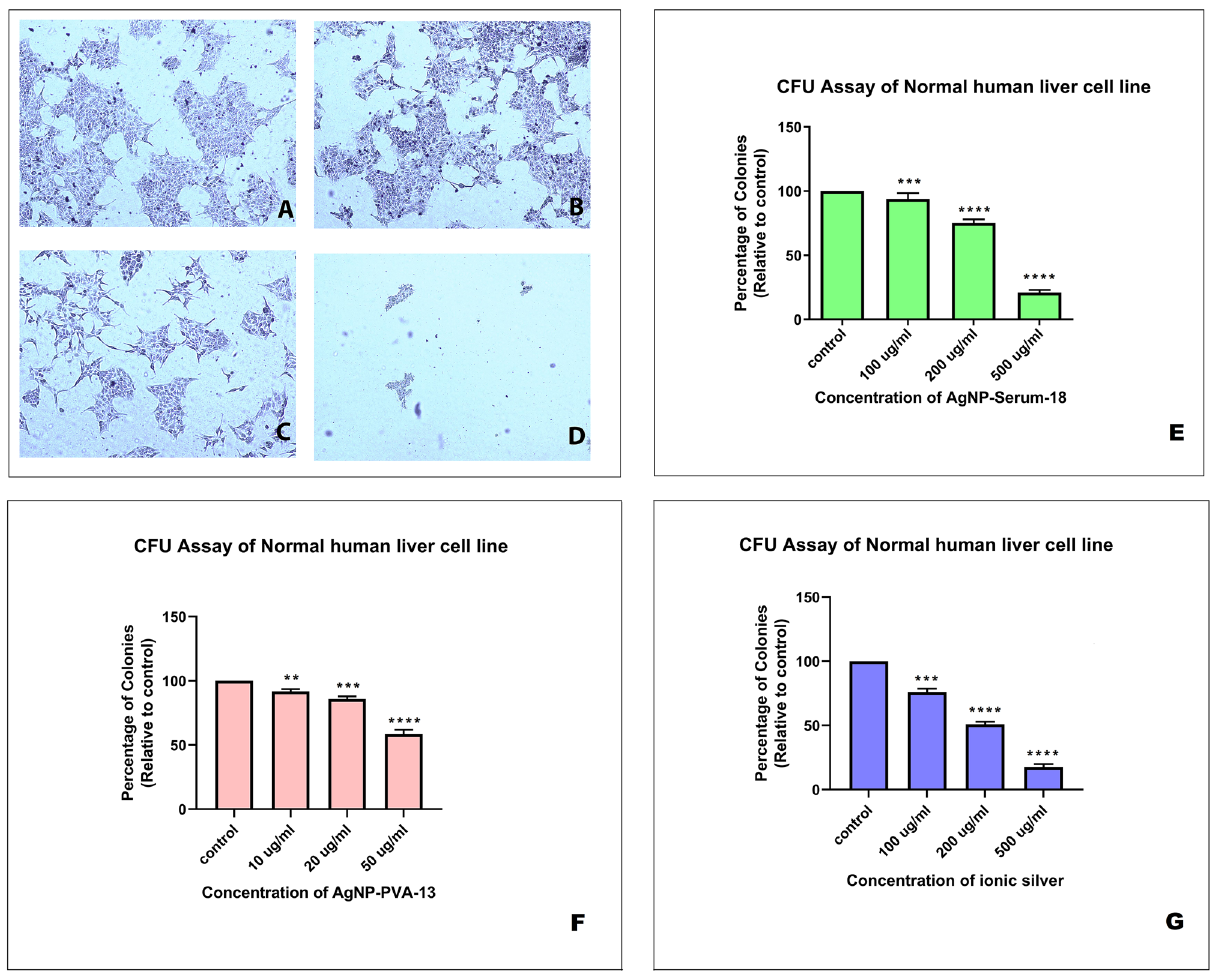
Figure 5. CFU assay. ( A ) Image of a normal human liver cell line (control); ( B ) cell line with the treatment of AgNPs-Serum-18 at 100 µg/mL silver equivalent concentration; ( C ) cell line with the treatment of AgNPs at 200 µg/mL silver equivalent concentration; ( D ) cell line with the treatment of AgNPs at 500 µg/mL silver equivalent concentration; ( E ) percentage inhibition of colony number on normal human liver cell line after treatment of AgNP-Serum-18 at various concentrations; ( F ) percentage inhibition of colony number on normal human liver cell line after treatment of AgNP-PVA-13 at various concentrations as a control; ( G ) percentage inhibition of colony number on normal human liver cell line after treatment of ionic silver at equivalent concentrations of AgNP-Serum-18 as a control. Data are expressed as means ± SD. There was significant difference between the treated and control groups (** P < 0.01; ***P < 0.001; ****P <